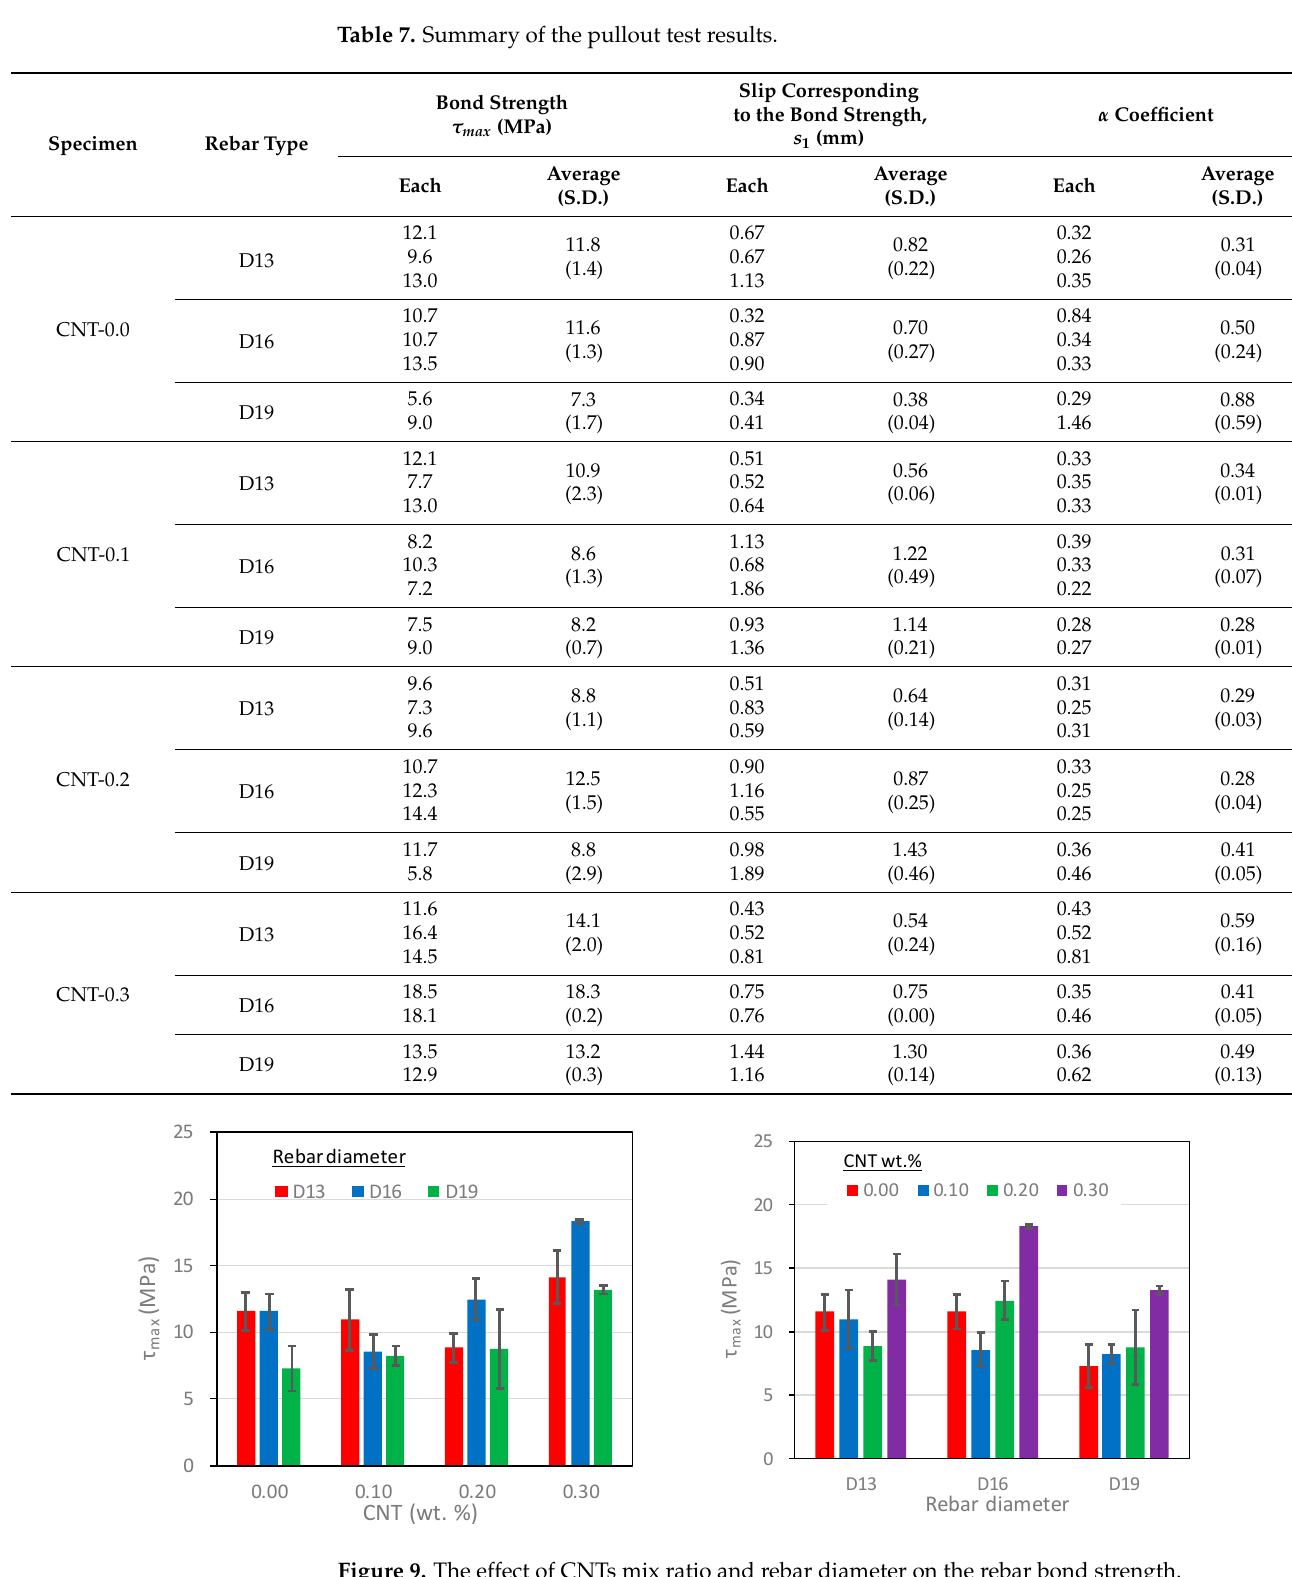
Figure 9. The effect of CNTs mix ratio and rebar diameter on the rebar bond